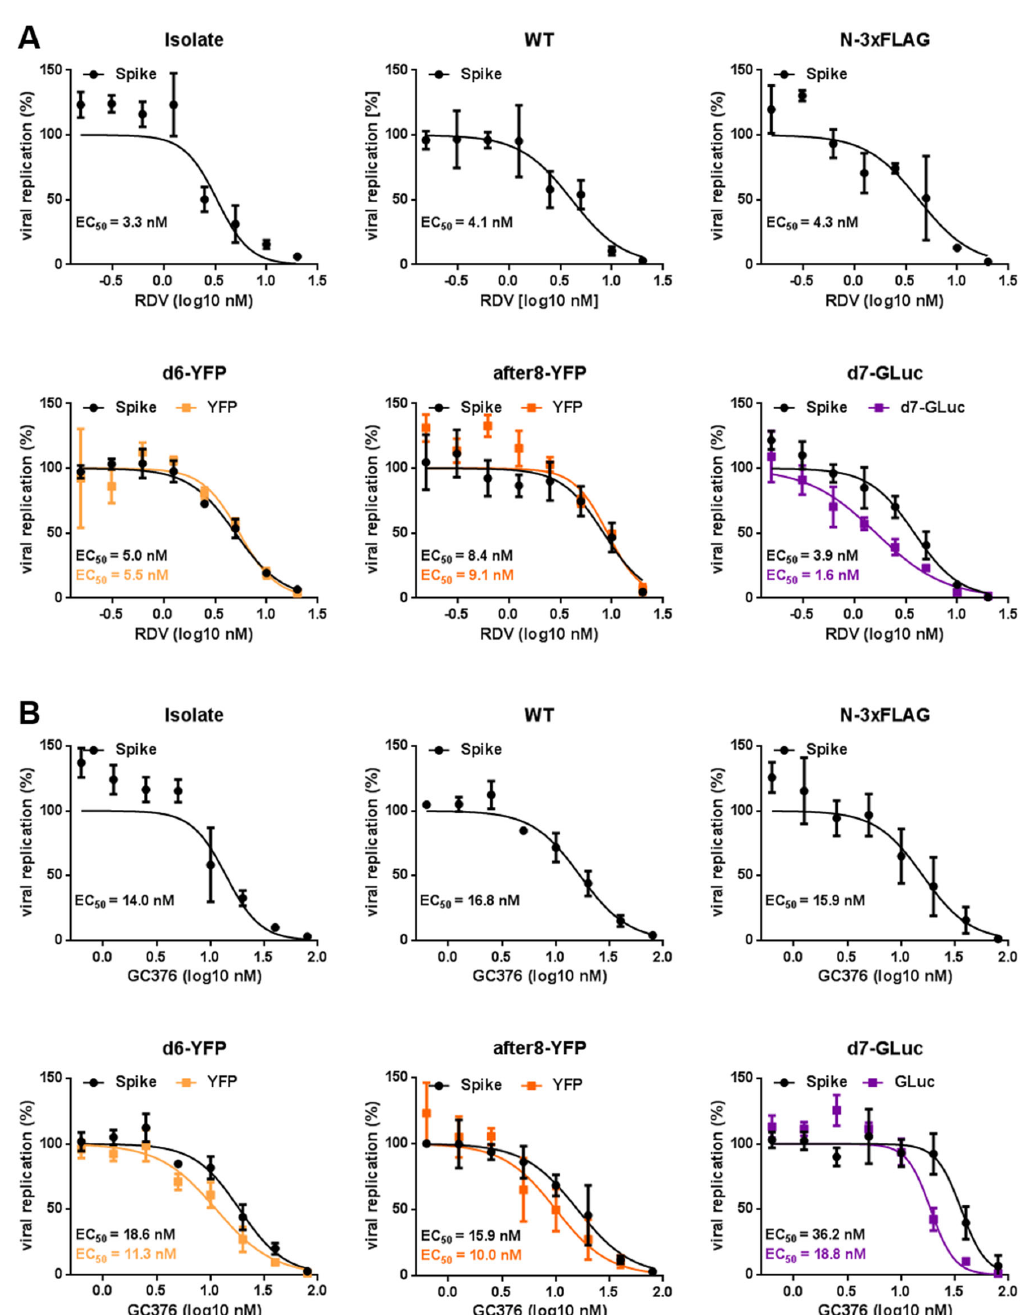
Figure 4. Dose response of the recSARS ‐ CoV ‐ 2 reporter viruses to RDV and GC376. CaCo ‐ 2 cells were infected with the clinical isolate, the recSARS ‐ CoV ‐ 2 WT, the N ‐ 3xFLAG marker virus, fluorescence reporter viruses expressing YFP instead of ORF6 (d6 ‐ YFP) or between ORF8 and N (after8 ‐ YFP), and the luciferase reporter virus d7 ‐ GLuc, which expresses gaussia luciferase instead of ORF7a (MOI = 0.005). At the same time, the cells were treated with 2 ‐ fold serial dilutions of remdesivir (RDV) ( A ) or GC376 ( B ). The cells were harvested at 30 hpi, and viral replication was determined by the quantification of spike expression (immunostaining with mAb against spikes), fluorescence reporter, or luciferase expression, respectively. The percentage of viral replication was determined relative to the solvent ‐ treated cells. The 50% effective concentration (EC 50 ) was assessed by nonlinear four ‐ parameter curve fitting using GraphPad Prism and are shown within the respective graphs. Mean values of quadruplicates relative to the solvent ‐ treated cells ± SD are depicted.